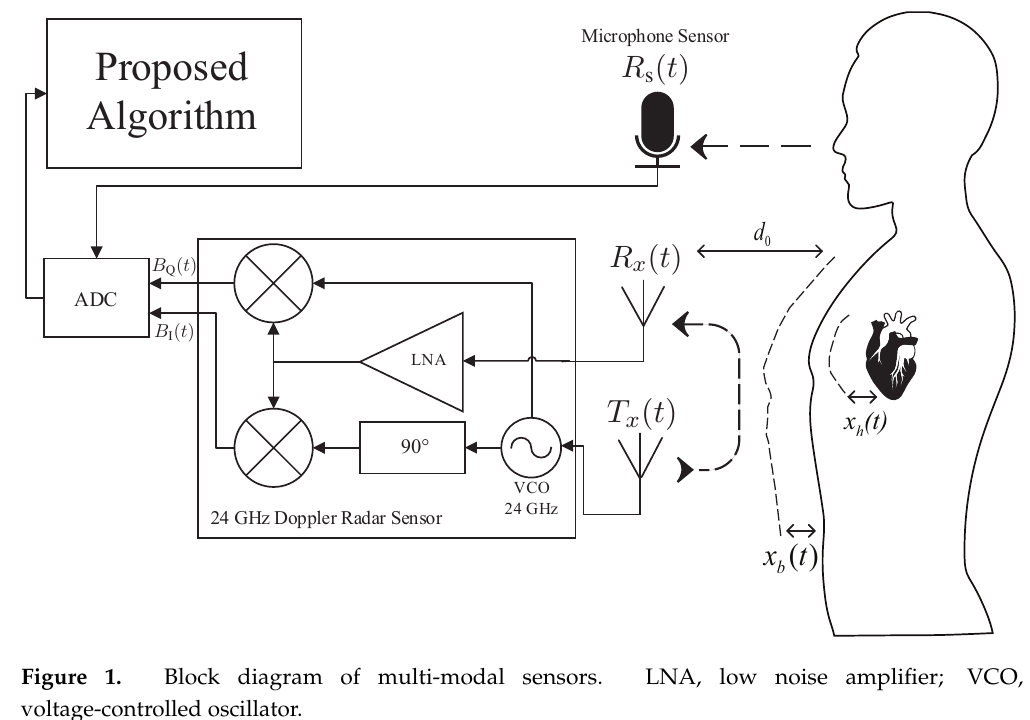
Figure 1. Block diagram of multi-modal sensors. LNA, low noise amplifier; VCO, voltage-controlled